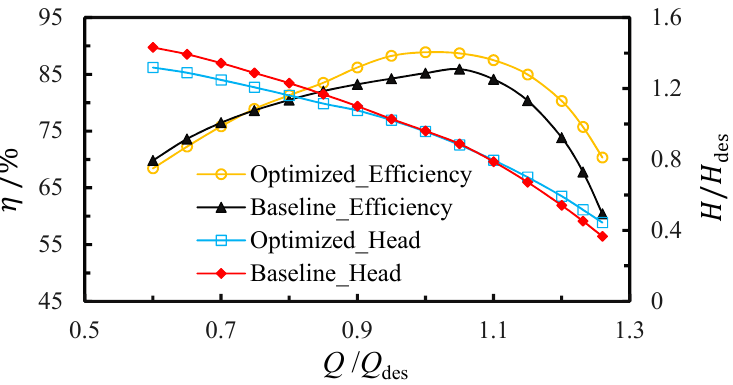
Figure 12. Performance comparison between optimized model and baseline model.